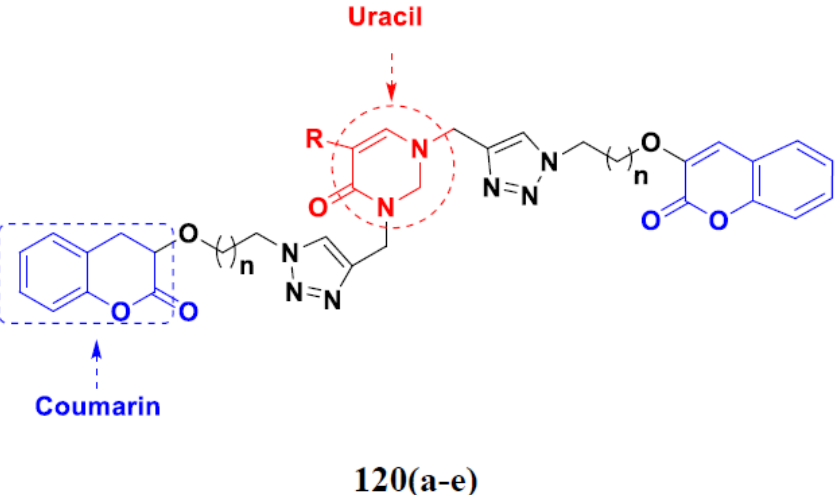
Figure 114. Structure of coumarin ‐ based uracil derivatives 120 ( a – e ). Table 101. In vitro cytotoxic activities of coumarin ‐ based uracil hybrid compounds 120 ( a – e ).